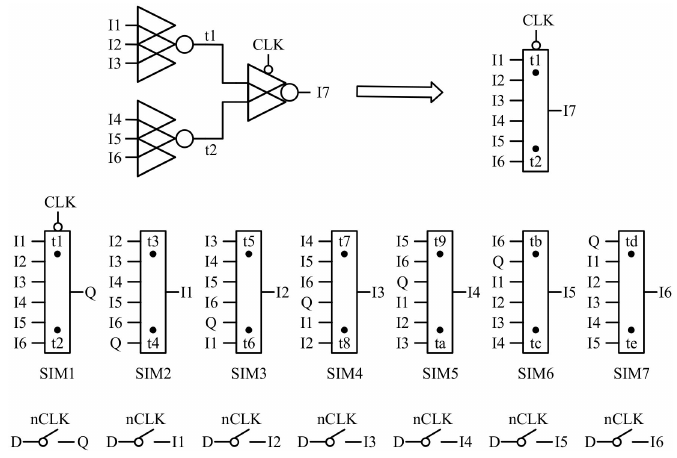
Figure 8. Schematic of TNURL latch.